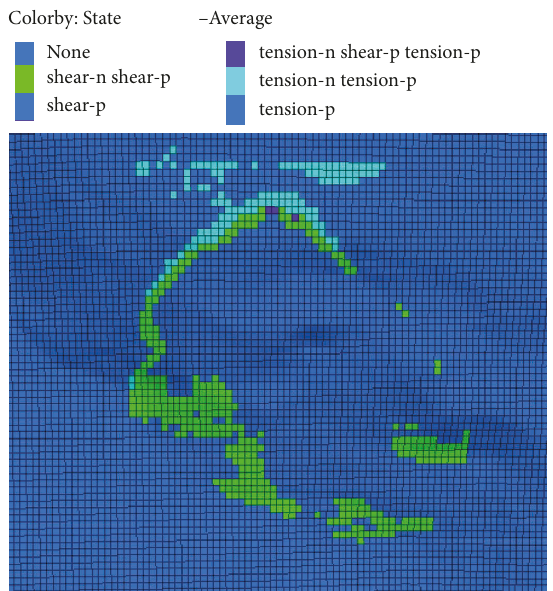
Figure 22: Plastic zone distribution under straight line layout.